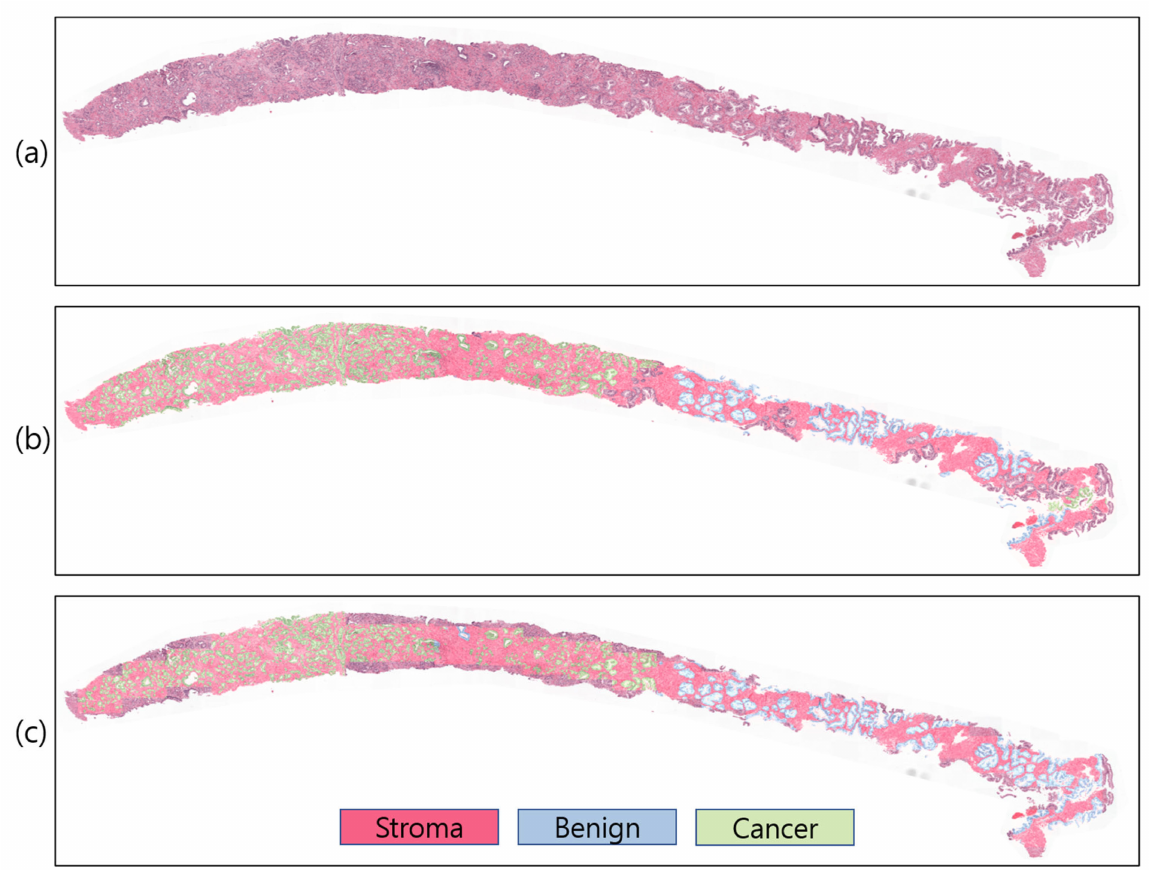
Figure 8. Slide-level prediction (stroma, benign, and cancer). ( a ) Original WSI. ( b ) Annotated WSI. ( c ) Predicted WSI. The slide-level visualization is carried out at 10 ×